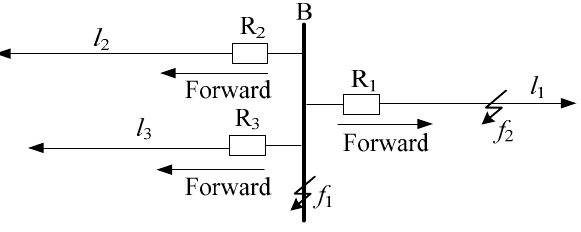
Figure 1. Fault circuit of a simple busbar structure.